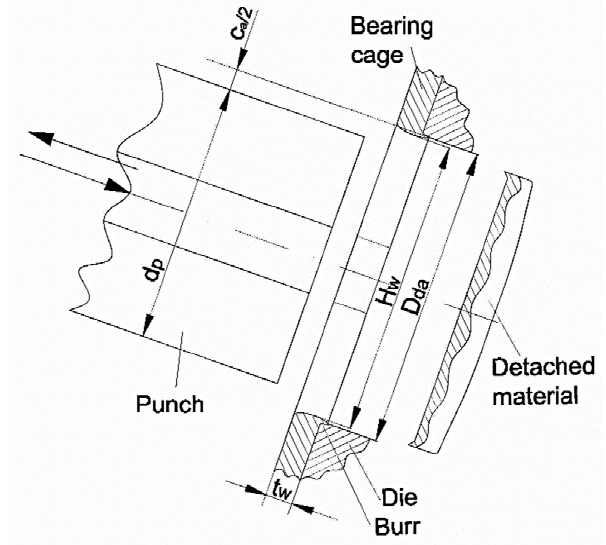
Figure 4. Window in the bearing cage after withdrawal of the punch.